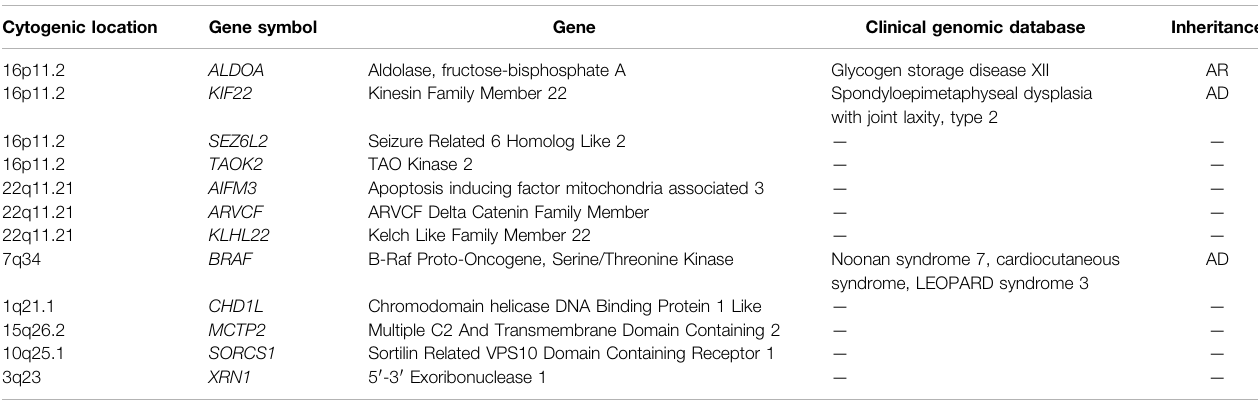
TABLE 2 | The cytogenic location for the 12 genes with identi fi ed rare variants. Cytogenic